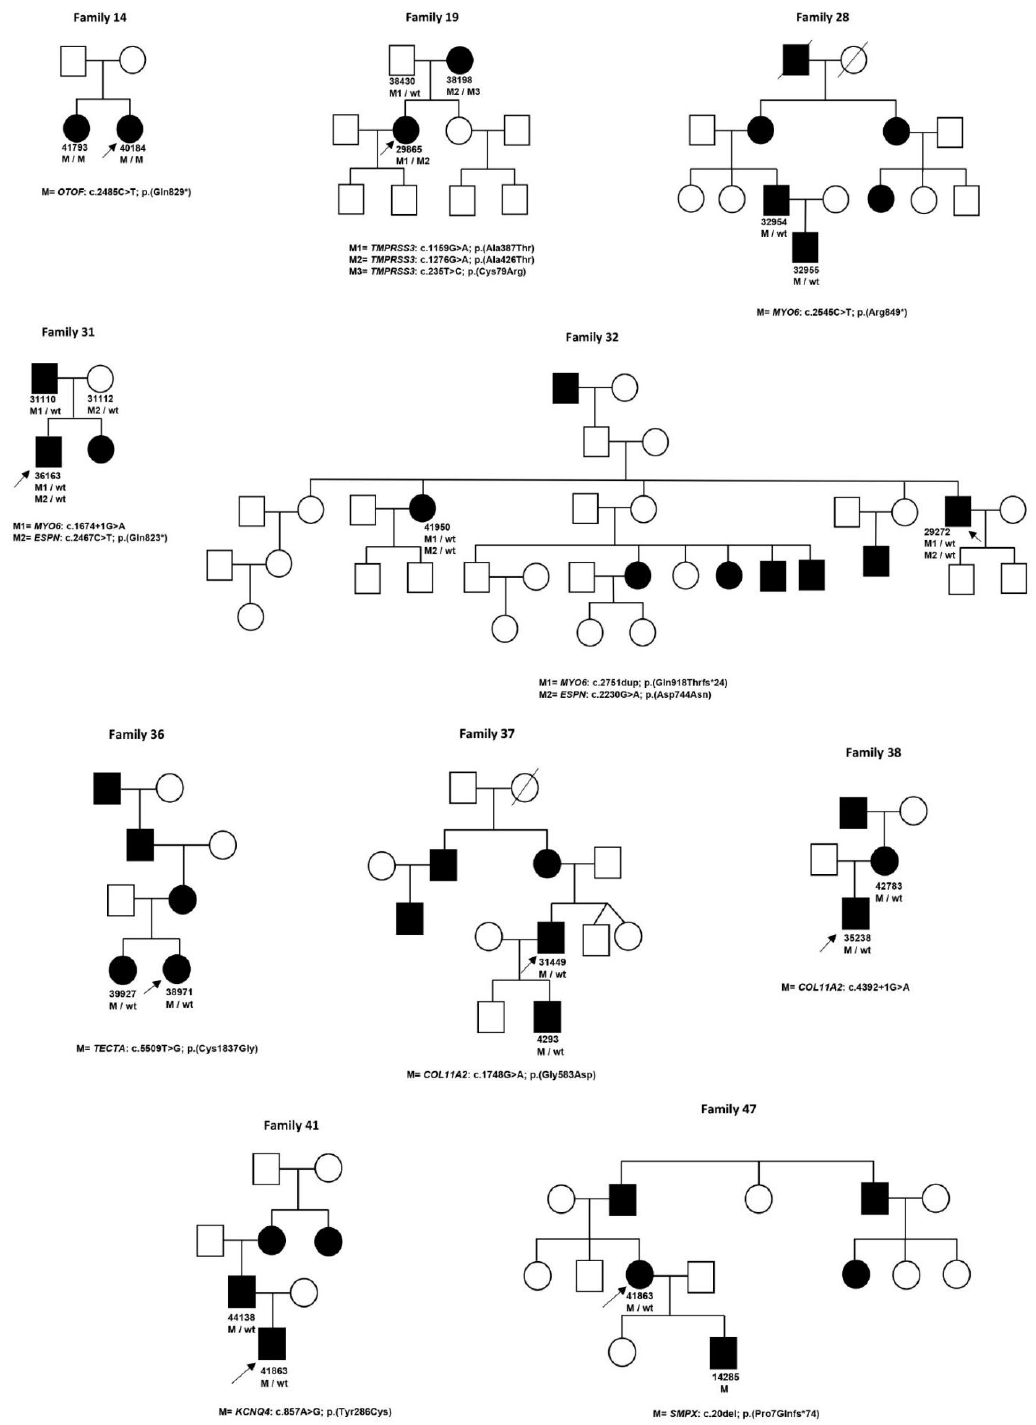
Figure 2. Pedigrees of the families and segregation analysis of the detected pathogenic or likely pathogenic variants. Arrows indicate the proband case, M indicates the pathogenic or likely pathogenic variant and wt indicates wild type sequence.